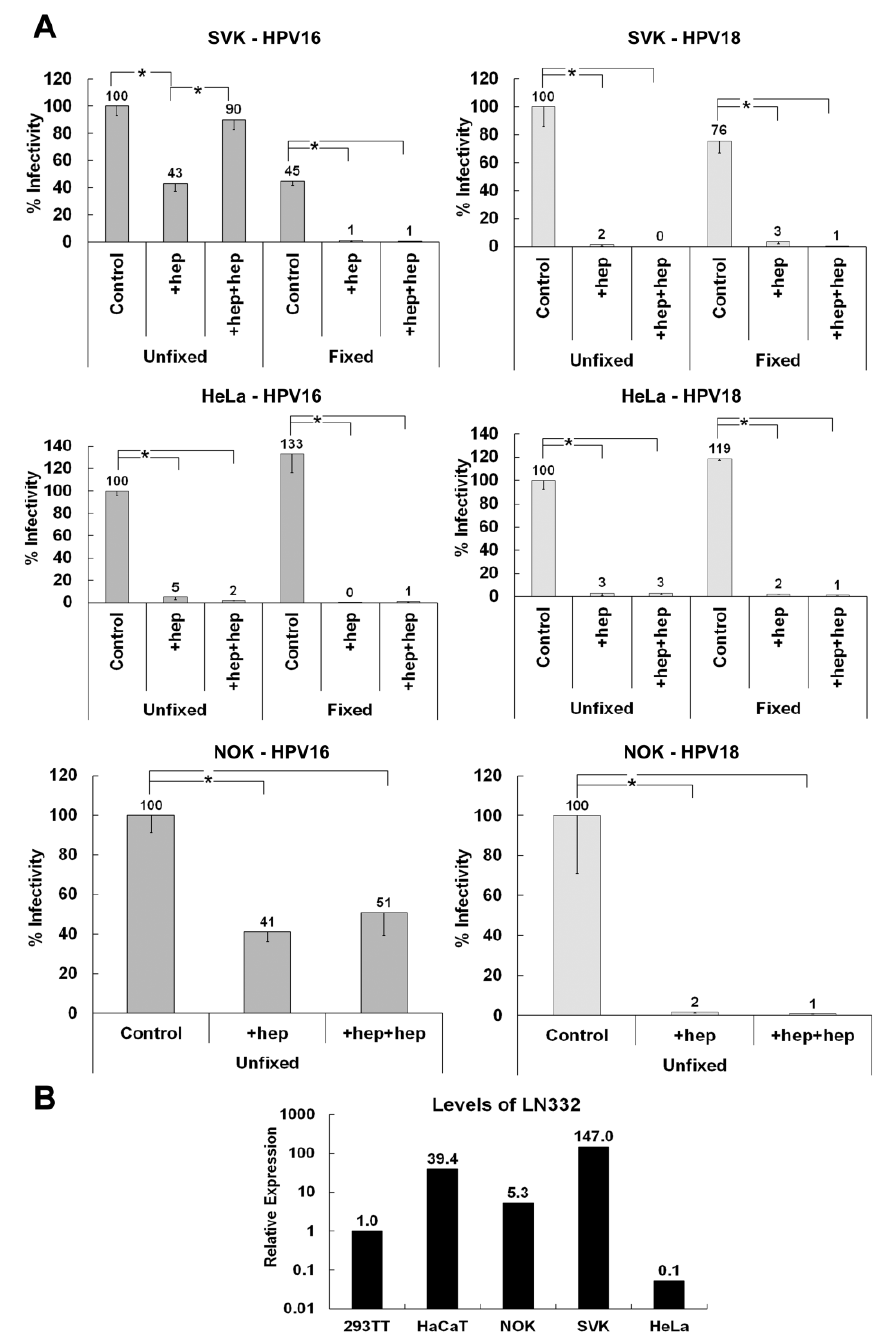
Figure 5. Investigating the ability of HPV16 and HPV18 to utilize the ECM of various cell lines for infectious transfer. ( A ) HPV16 and HPV18 viruses were allowed to bind to the ECM secreted by SVK (SV40 transformed keratinocytes), NOK (normal oral keratinocytes) or HeLa cells in the presence or absence heparin at a 10 μg/mL. Indicator 293TT cells were added and infection was scored 72 hpi; ( B ) Expression levels of LAMC2 (LN332) were determined using qRT-PCR on total RNA isolated from indicated cells. All graphs show average values from at least three experiments containing triplicates. When the statistical significance of a data set as determined by a Student’s t -test differed from control by p ≤ 0.001, it is indicated in the graph ( *